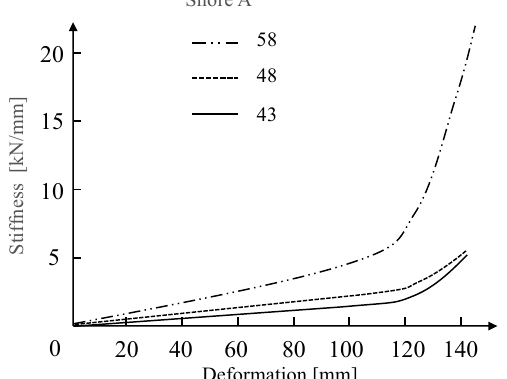
Figure 2. Stiffness–deformation curve of the GINA gasket (redrawn according to the results of Peng et al. [19]).